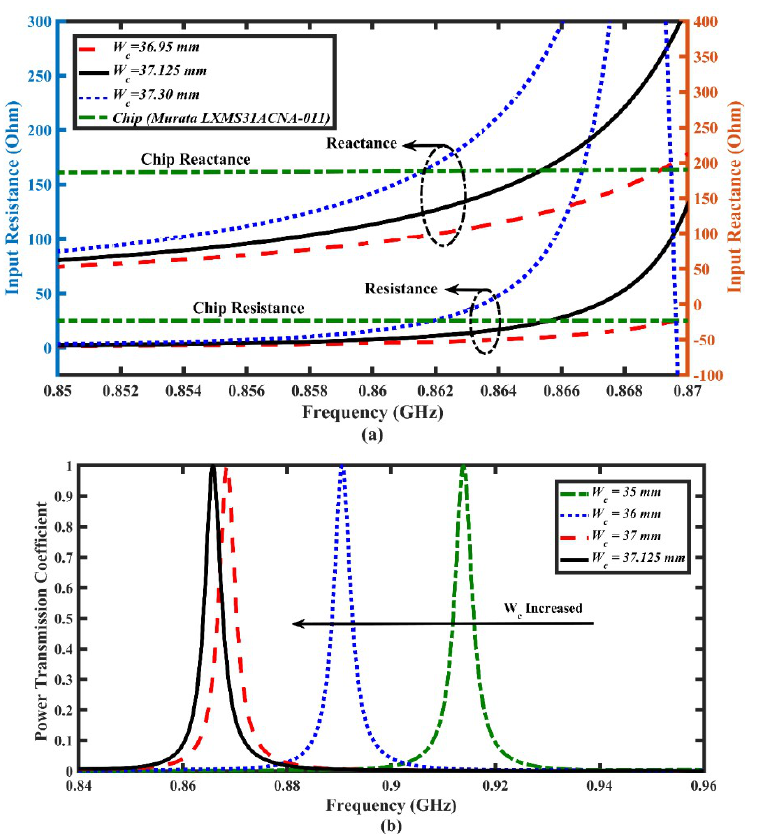
Figure 4. ( a ) simulated antenna’s input impedance for di ff erent W c values; ( b ) power transmission coe ffi cient for various W c values.